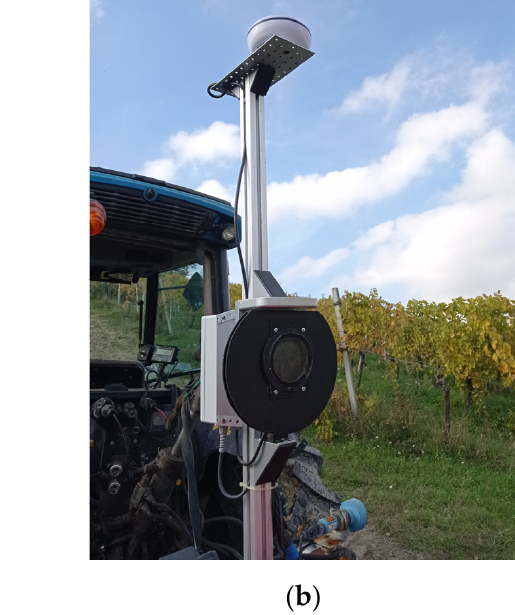
Figure 1. Workstation for experimental operation composed of: ( a ) a conventional sprayer. ( b ) Complex system for data acquisition composed of LiDAR sensor, GPS, IMU and controller.